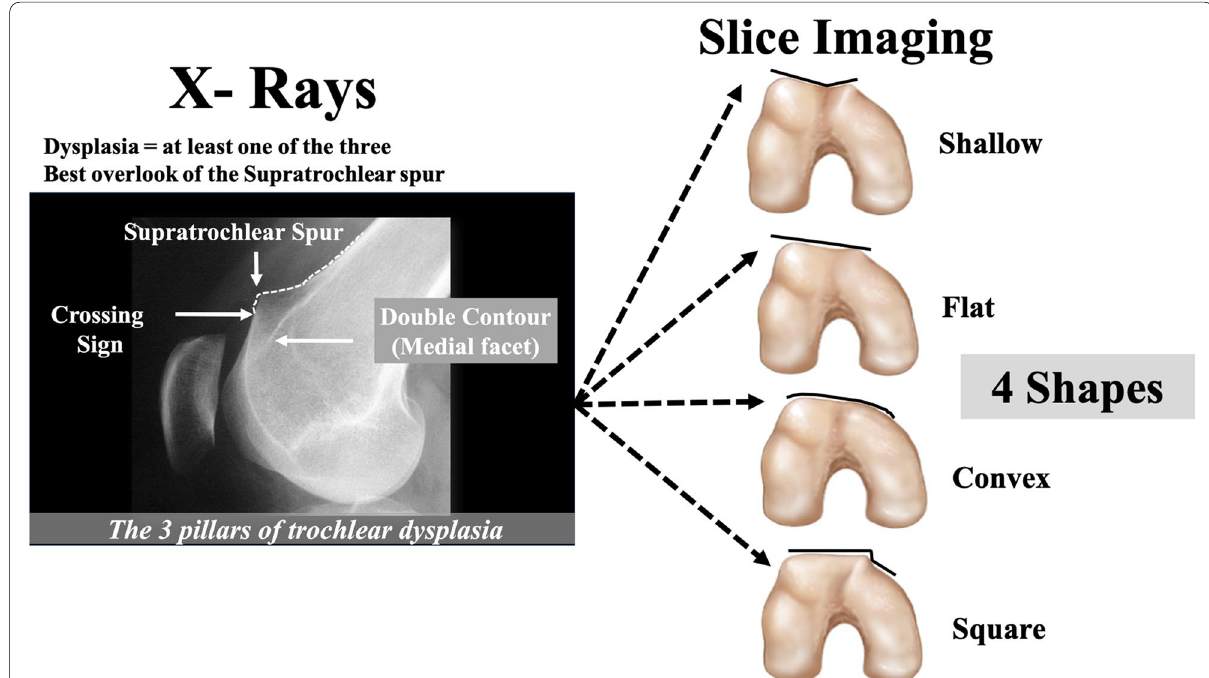
Fig. 1 Two Imagings are mandatory to screen the trochlear dysplasia. X-Ray shows the 3 pillars of trochlear dysplasia. Slice imaging gives the shape of the trochlea but not the supratrochlear spur